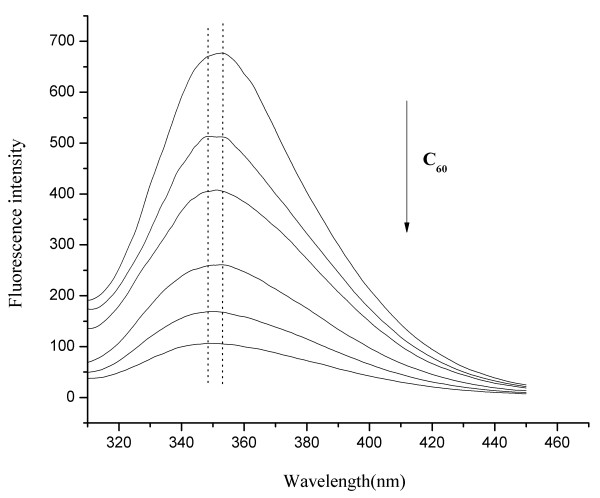
Stern-Volmer plots of HSA and BSA fluorescence quenching by C60nanoparticles. (F0: The fluorescence intensity of BSA/HSA in the absence of C60; F: The fluorescence intensity of BSA/HSA in the presence of C60).